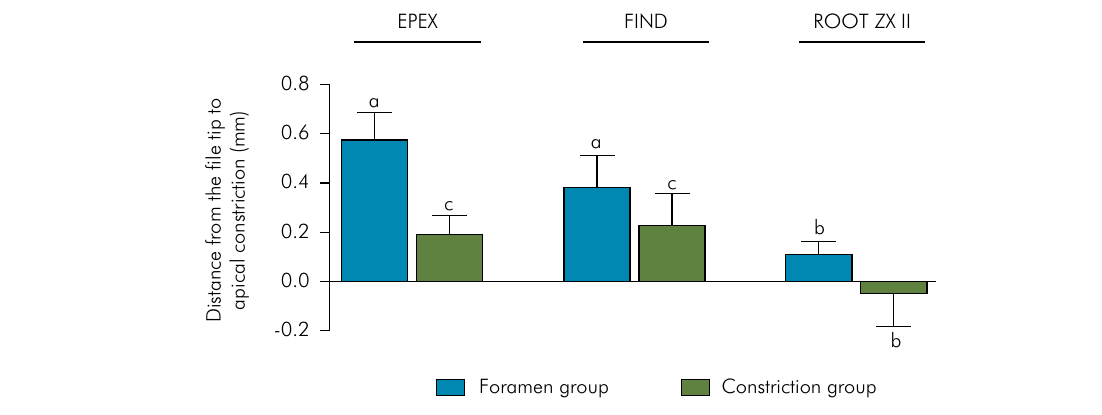
Figure 1. Distances (mm) recorded from the tip of the endodontic file to the apical constriction. Different letters indicate statistical difference (p < 0.05)